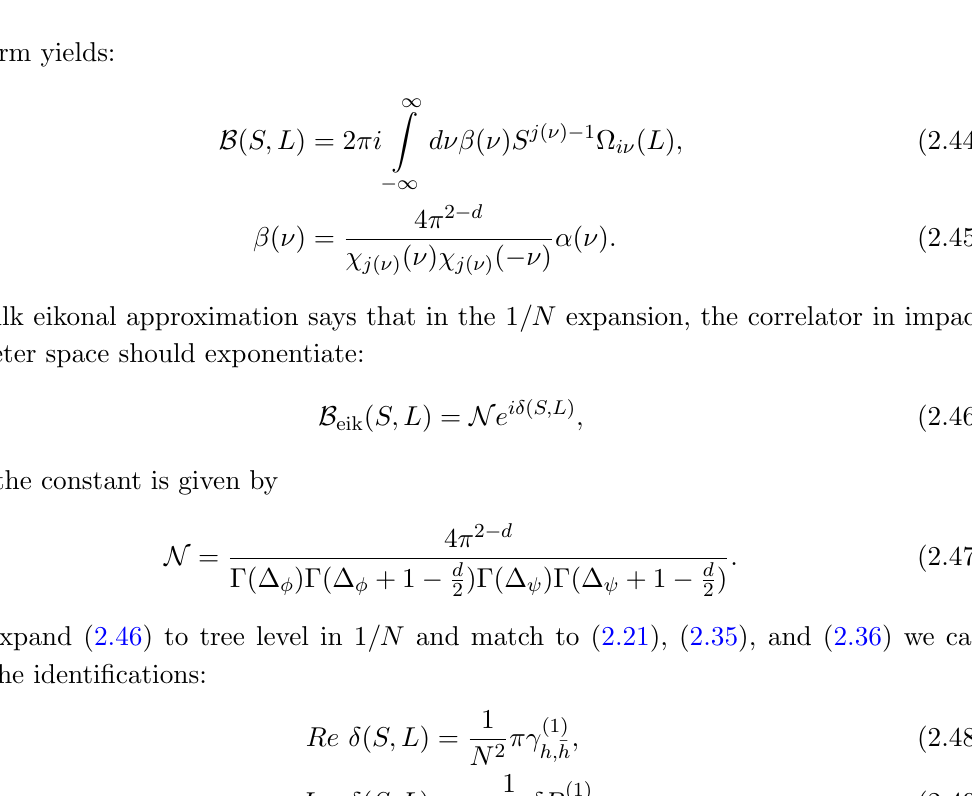
Figure 3 . High-energy, (cid:12)xed impact parameter scattering in AdS. The boundary operators are centered around P i , the centers of di(cid:11)erent Poincar(cid:19)e patches. The impact parameter space is the spatial H d (cid:0) 1 slice, drawn in